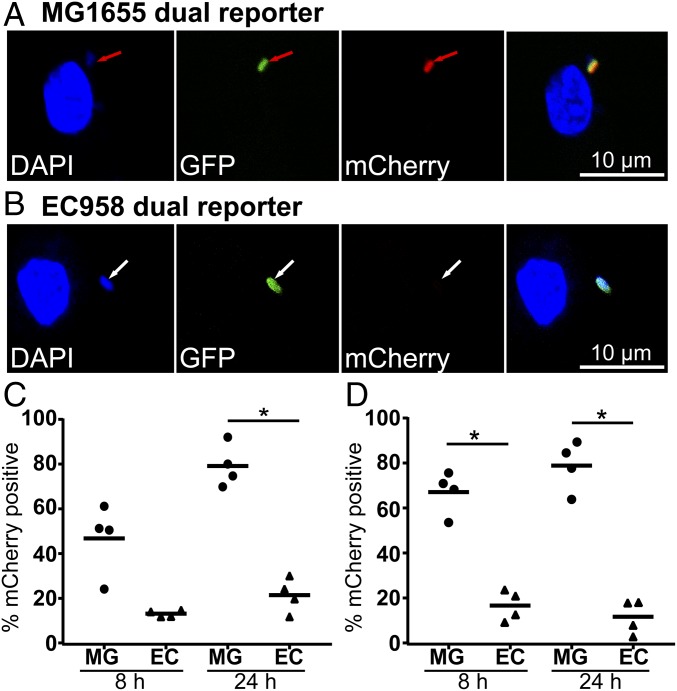
A dual reporter system confirms that EC958 evades the zinc stress response of human and mouse macrophages. (A–C) HMDM or (D) BMM were infected with MG1655 pGcCzntAp (MG) or EC958 pGcCzntAp (EC) (MOI of 100) for 1 h, followed by gentamicin exclusion. At 8 or 24 hpi, cells were fixed and stained with DAPI, then imaged for mCherry, DAPI, and GFP. The percentage of mCherry+/GFP+ viable bacteria was recorded for multiple images taken at each time point, and an average value for MG1655 and EC958 was determined at 8 and 24 hpi A and B are representative images of HMDM infected with (A) MG1655 or (B) EC958 at 8 hpi (red arrows: mCherry+ bacteria; white arrows: mCherry− bacteria). Data in C and D are combined from four independent experiments (horizontal bars indicate mean, *P < 0.05, one-way ANOVA with Sidak’s multiple comparisons test). Assays were performed in parallel for MG1655 and EC958.